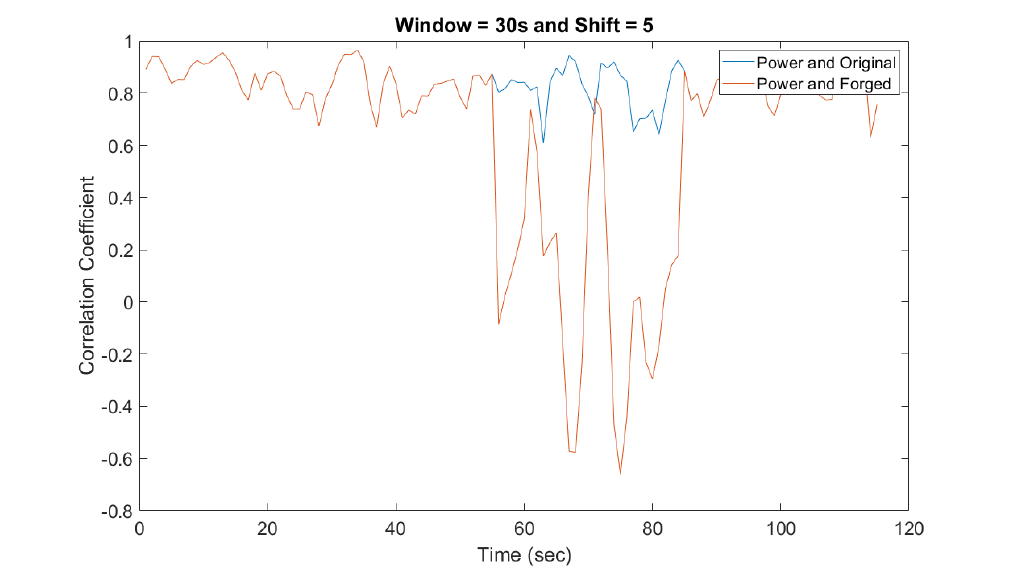
Figure 16. Detecting the forged audio recording using correlation